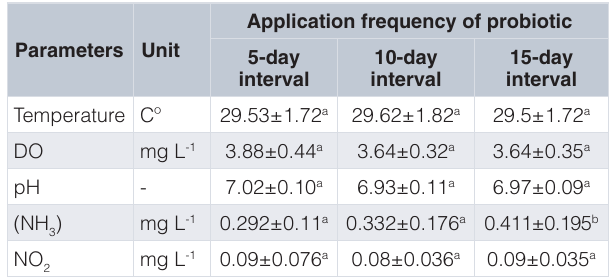
Table 2. The main water quality parameter of the cultured media of African catfish ( Clarias gariepinus ).